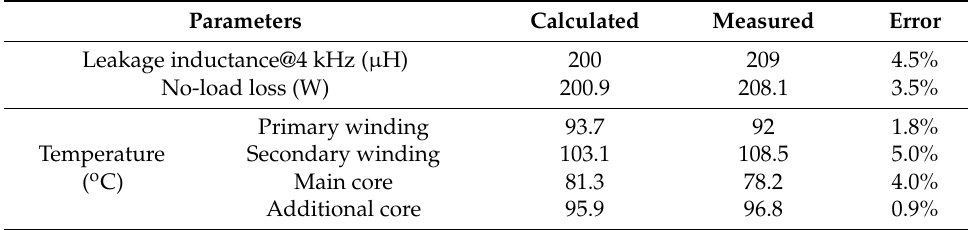
Table 3. Experimental